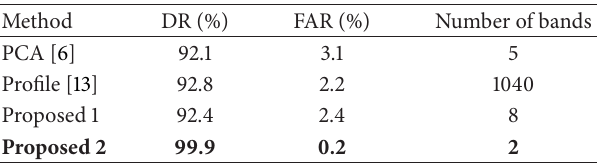
Table 3: Comparison of the abnormal region detection methods for the hair